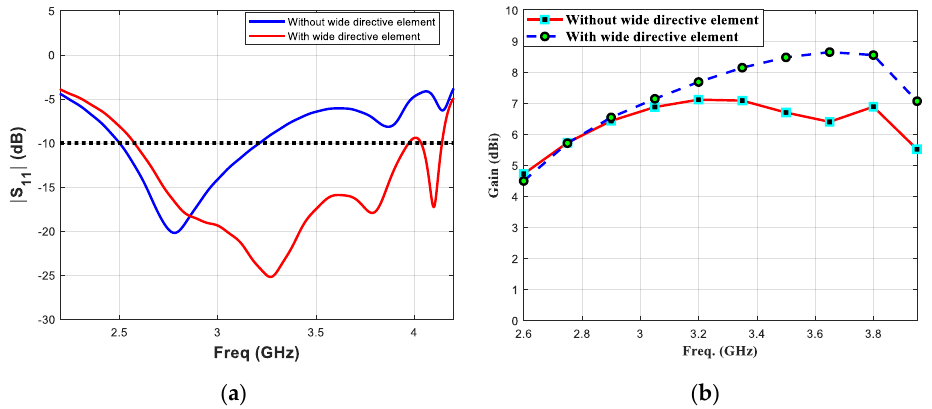
Figure 4. Comparison of ( a ) reflection coefficient (S 11 ) and ( b ) realized gain parameters of the proposed antenna element, without and with tightly coupled wide directive element.